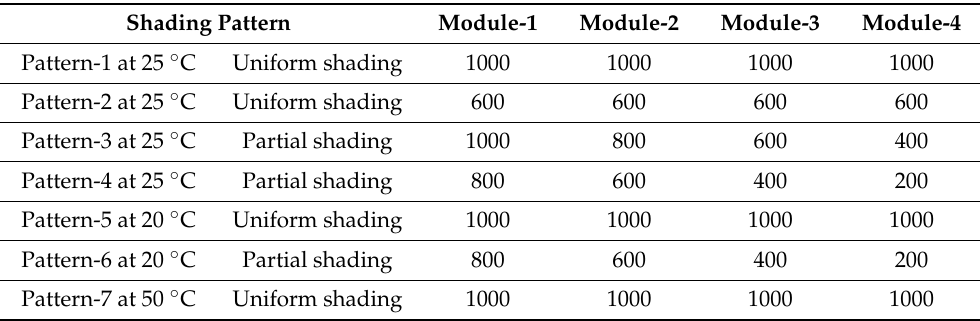
Figure 6. A 4S structure of PV array system ( a ). Pattern-1, ( b ). Pattern-2, ( c ). Pattern-3, ( d ). Pattern-4. Table 4. Shading patterns of PVS for different solar irradiation ( G ).